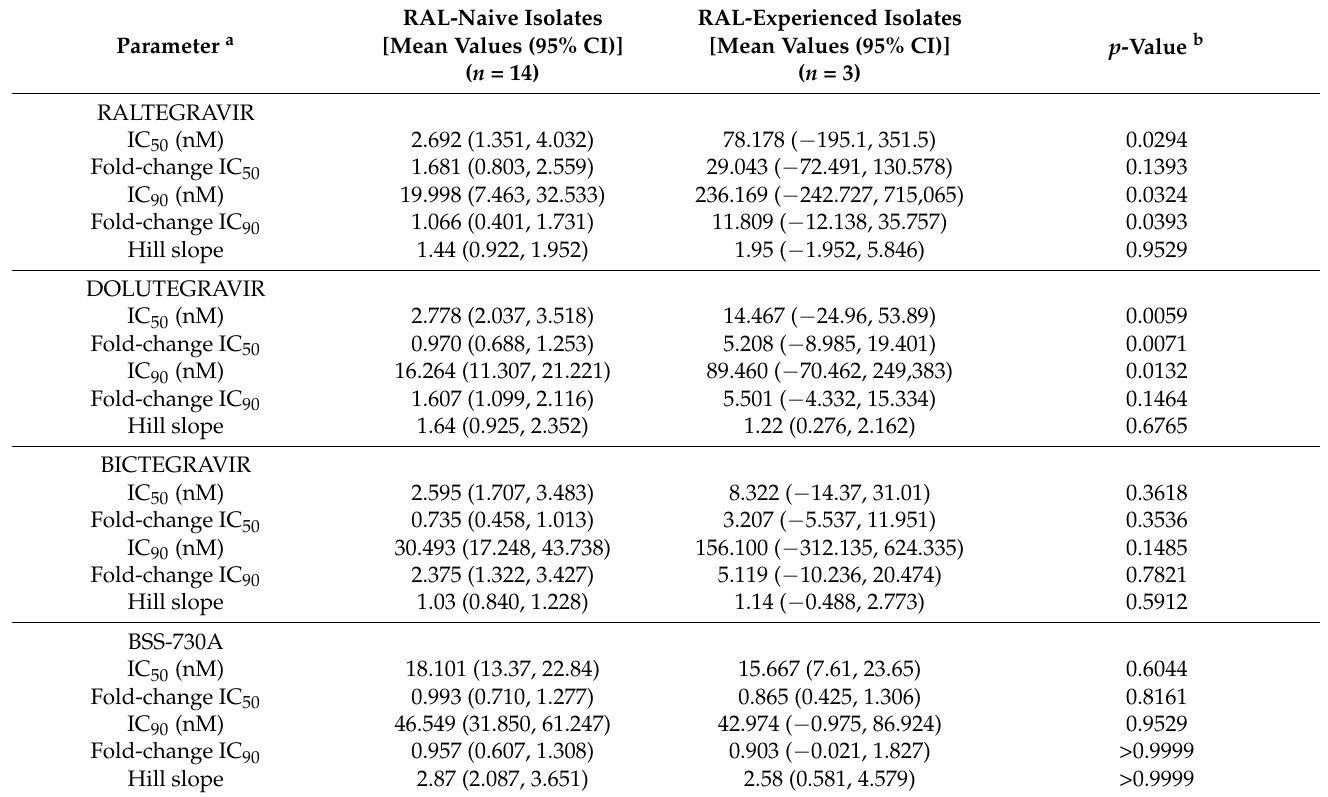
Table 1. Comparison of the antiviral activity of the different drugs against isolates from RAL-naïve and RAL-experienced